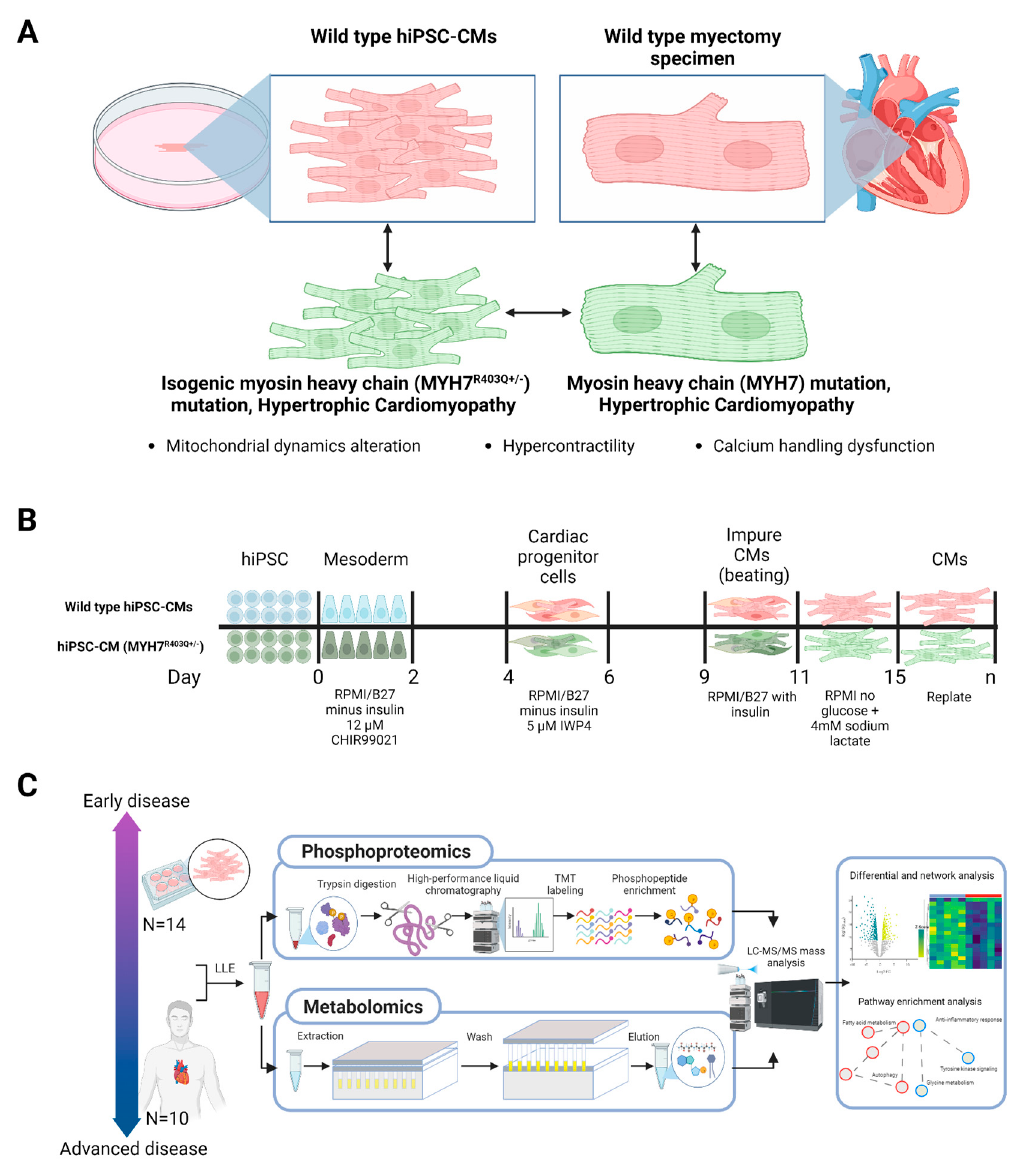
Figure 1. Study design and mass spectrometry workflows. ( A ) Schematic of wild-type and MYH7 mutant human induced pluripotent stem-cell-derived cardiomyocyte (hiPSC-CM) and clinical (my- ectomy) specimens. ( B ) hiPSC-CMs differentiation protocol; cultures were differentiated over 20 days from CRISPR/Cas9-edited MYH7 R403Q+/ − hiPSCs via targeted small-molecule, monolayer ma- nipulation of the Wnt signaling pathway. ( C ) Sample processing followed by parallel mass spec- trometry-based phosphoproteomics and metabolomics and subsequent bioinformatic analysis; LLE = liquid–liquid extraction, LC/MS = liquid chromatography/mass spectrometry, TMT = tandem mass tag. From our initial proteomic analysis, we identified and quantified 7829 proteins be- tween the mutant and control (WT) hiPSC-CM samples (Figure 2A). Differential proteome analysis revealed 648 statistically significant proteins (moderated Student t -test, false dis- covery rate (FDR) adjusted p < 0.05) (Figure 2B, Supplementary Table S1A, Supplementary Figure S1) [25]. From this set, we captured differential components linked to myofibrillary function and stability, including elevated levels of troponin I (TNNI3), filamin-C (FLNC), and four and a half LIM domains protein 1 (FHL-1) [26,27]. Moreover, we observed